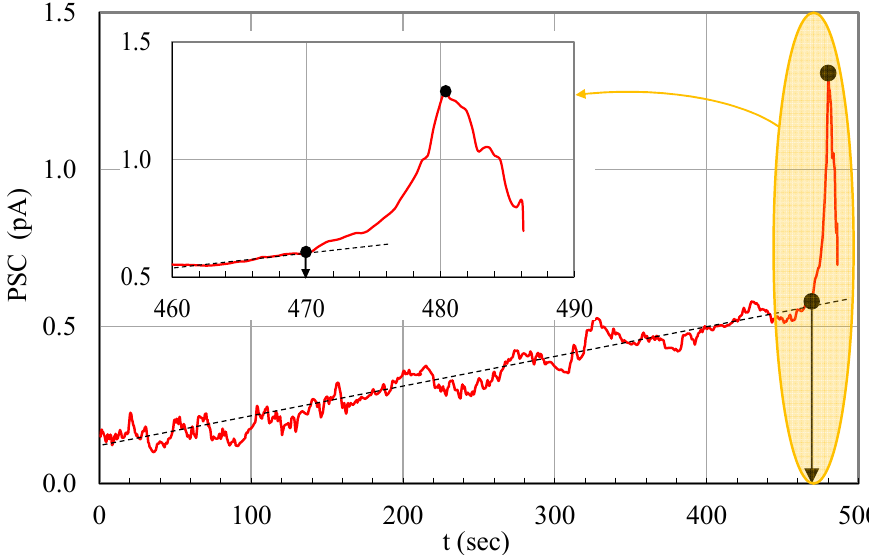
Figure 13. The temporal evolution of the PSC recorded during the diametral compression of the circular semi ring specimen discussed in Section 3.3.